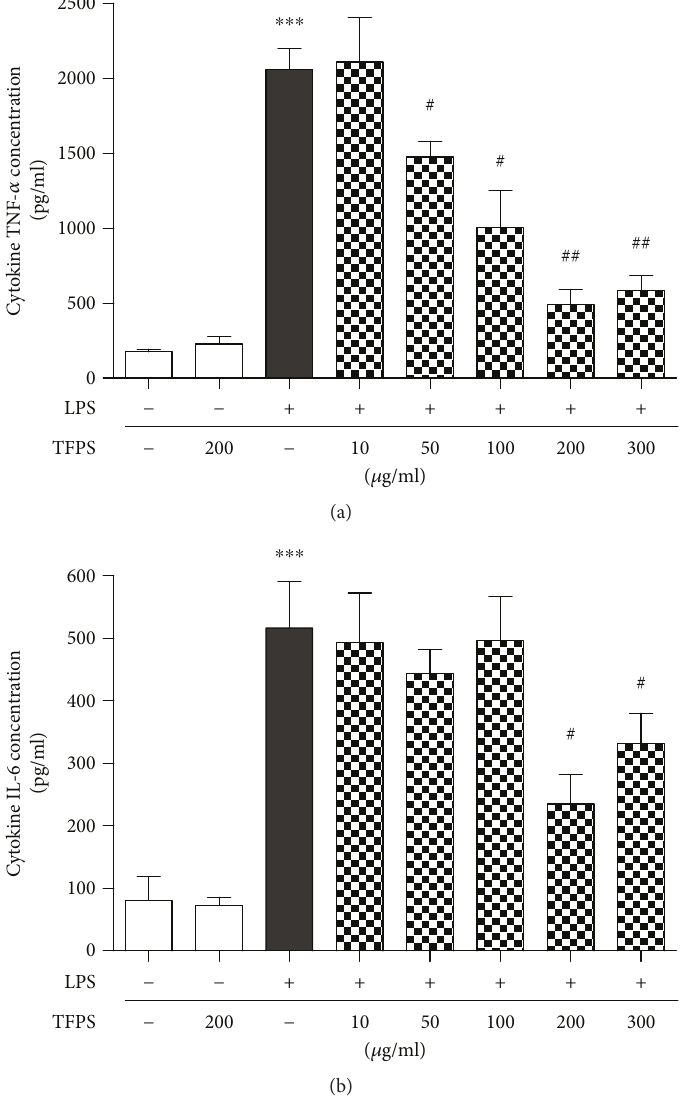
Figure 5: TFPS decreases the release of in fl ammatory factors that are produced during LPS-induced RAW264.7 cell injury. (a, b) ELISAs of TNF- α and IL-6 in control, TFPS-treated (200 μ g/ml), LPS-treated (1 μ g/ml), and 1 μ g/ml LPS-treated cells following TFPS pretreatments (10, 50, 100, 200, or 300 μ g/ml) of RAW264.7 cells for 1 h ( n = 3 , ∗∗∗ P < 0 001 versus control; # P < 0 05 , ## P < 0 01 versus the LPS